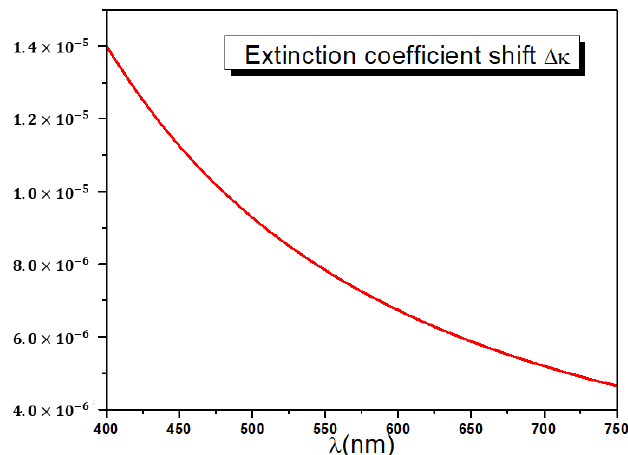
Figure 13. Extinction coefficient shift dispersion curves.